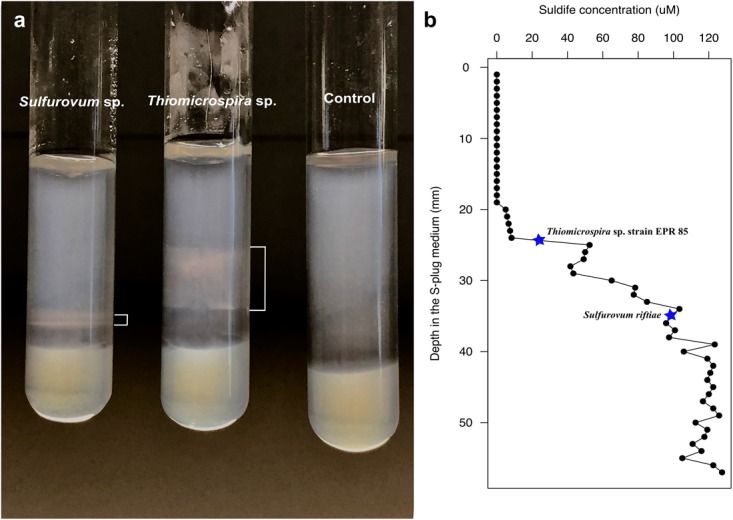
Growth of Sulfurovum riftiae and Thiomicrospira sp. strain 85 in sulfide gradient medium; (a) growth pattern in S-plug tubes; (b) Total sulfide concentration along the gradient. Stars indicate the total sulfide concentration for optimal growth of the two strains.